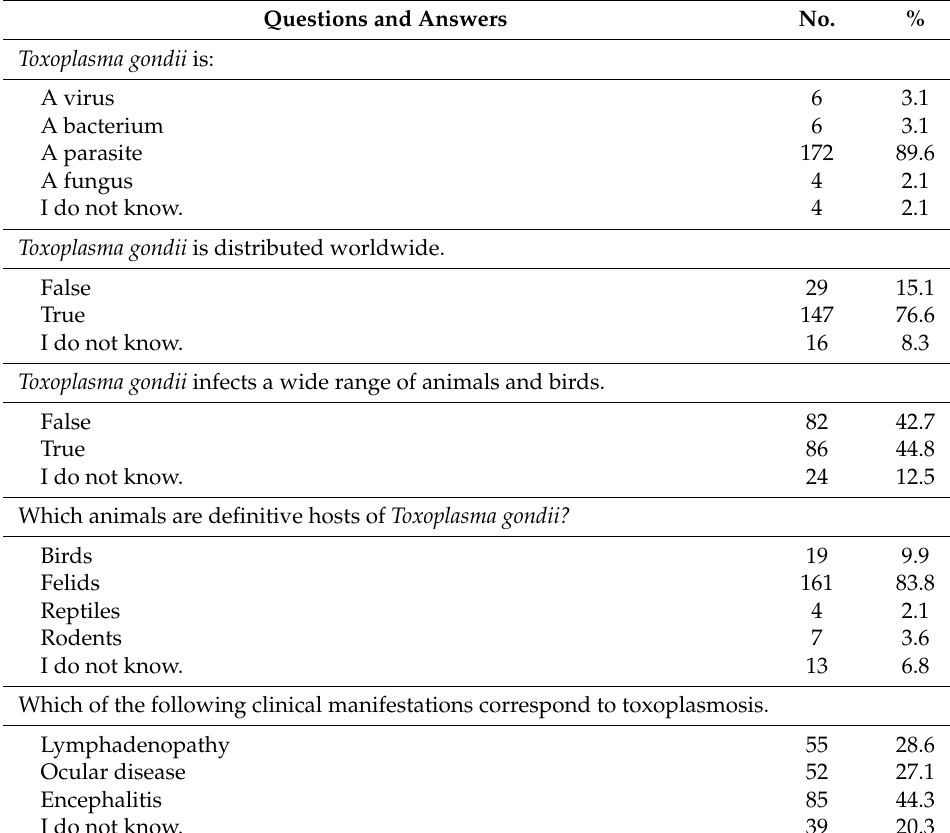
Table 2. Knowledge of Toxoplasma gondii and clinical aspects of